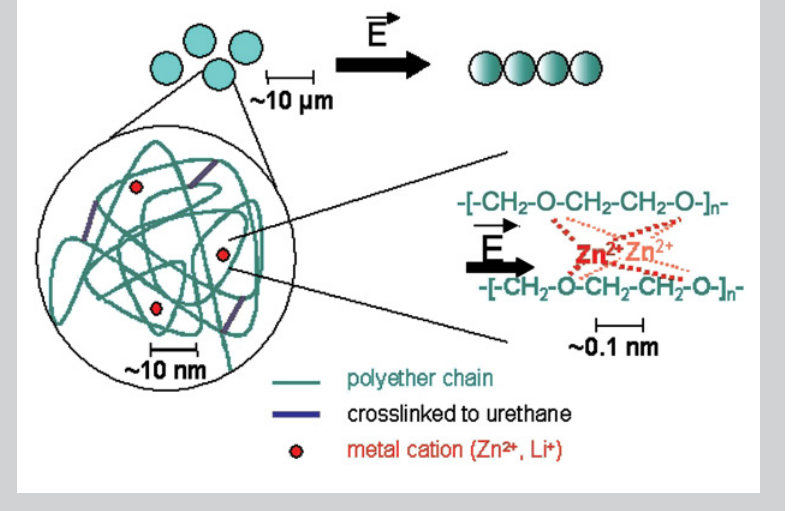
Figure 12: Model of the processes occurring during the polar- ization of polyurethane particles in the electric field Æ (E ), viewed at different magnitudes